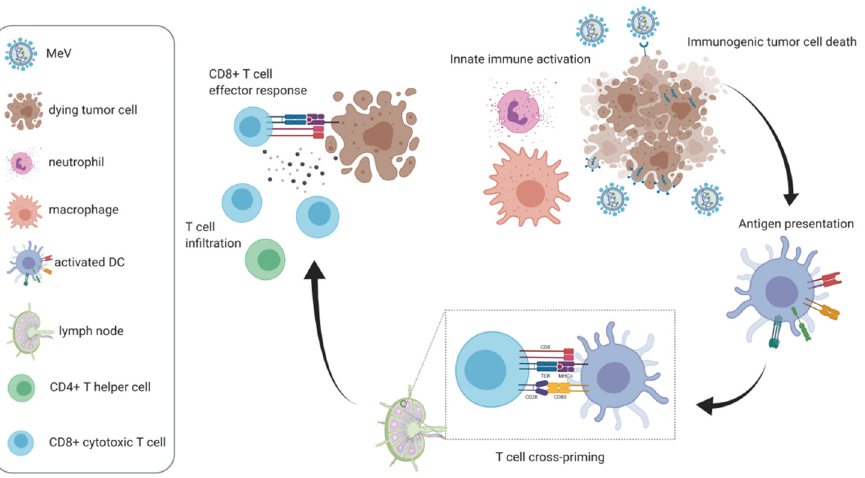
Figure 4. Measles virus as an oncolytic immunotherapy. Measles virus-mediated oncolysis has been shown to support different phases of the antitumor immune response: Oncolysis induces immunogenic cell death, which promotes dendritic cell activation, antigen presentation, and cross- priming of T cells. Measles virotherapy remodels the tumor microenvironment, thereby enhancing innate (macrophage repolarization and neutrophil degranulation) as well as adaptive antitumor immunity (T cell infiltration and CD8+ effector responses).